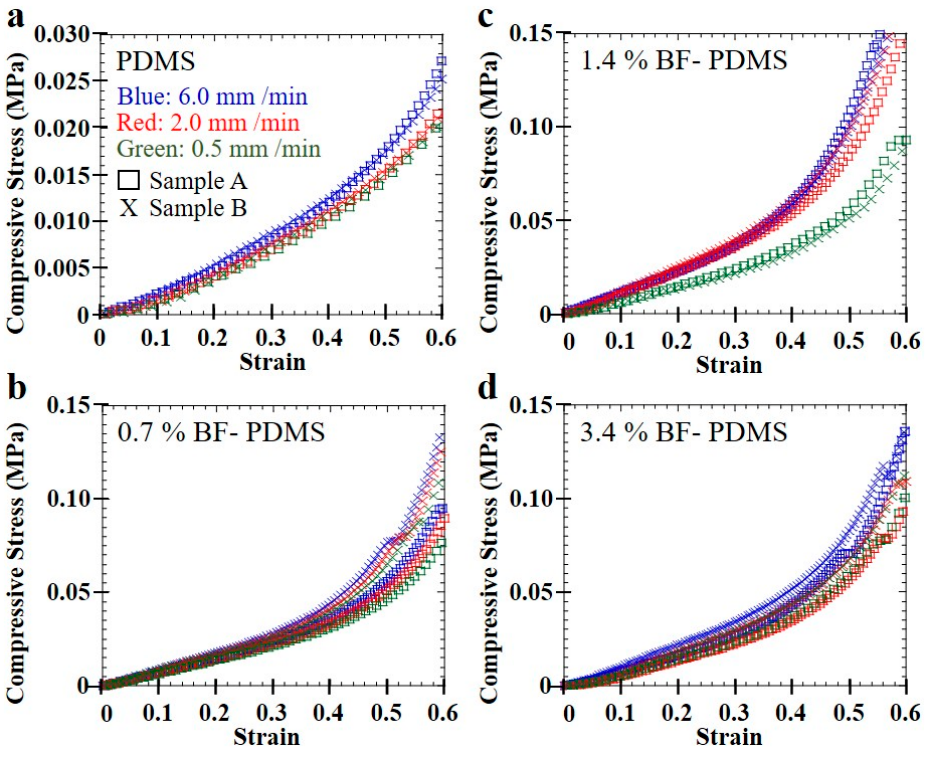
Figure 7. Compression stress–strain curves of ( a ) PDMS, ( b ) 0.7%, ( c ) 1.4%, and ( d ) 3.4% BF-PDMS.